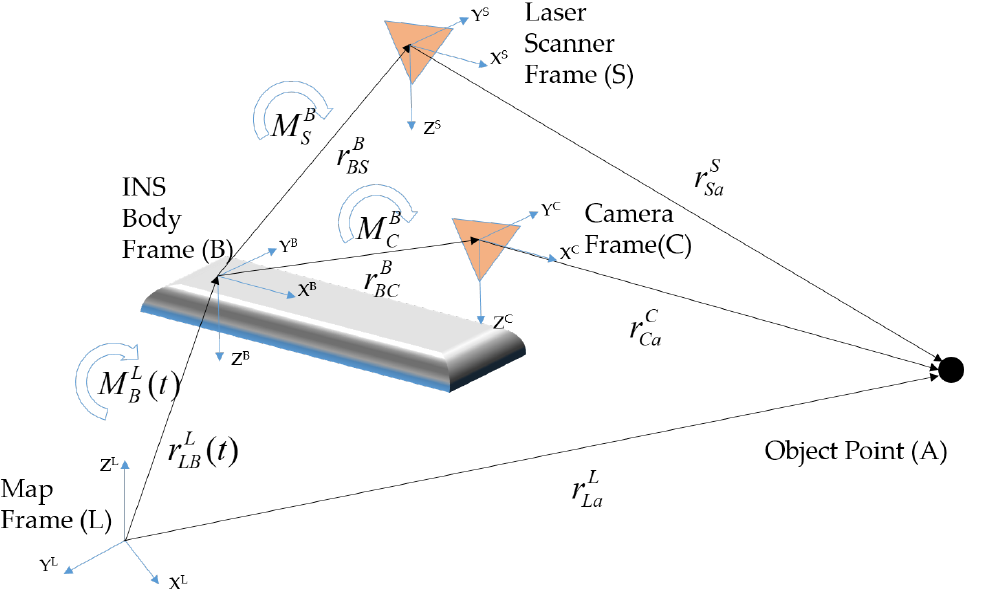
Figure 2. Spatial configuration of mobile mapping system (MMS) component devices.